Question: How would you classify this visualization?
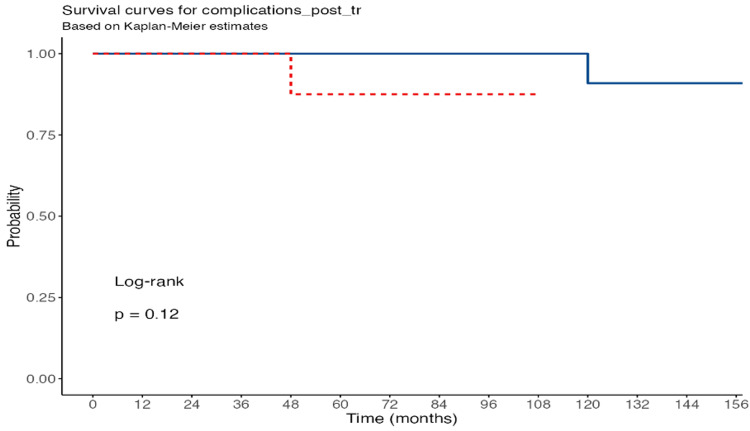
Answer: survival